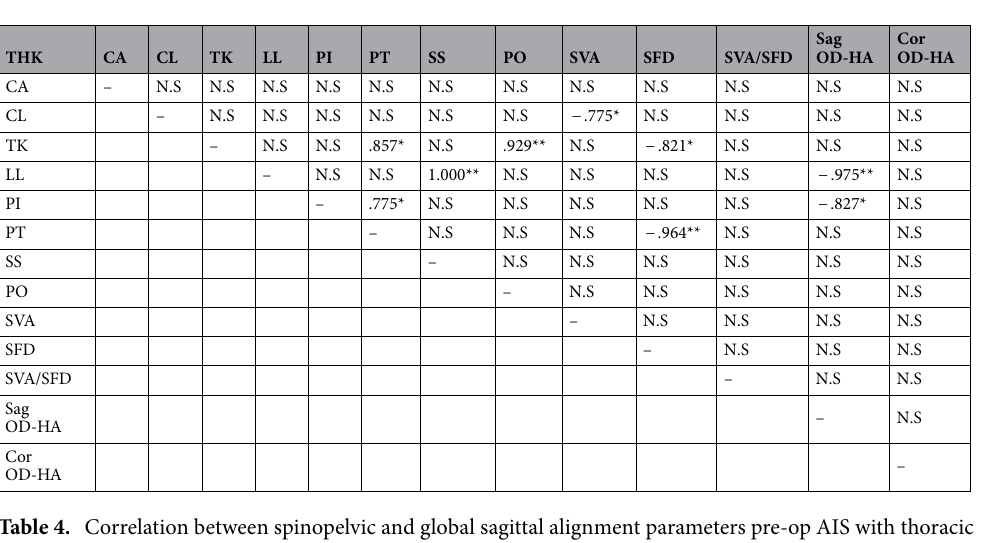
Table 4. Correlation between spinopelvic and global sagittal alignment parameters pre-op AIS with thoracic hypokyphosis (THK). Significance level: * P < 0.05, ** P < 0.01. THK thoracic hypokyphosis; CA Cobb